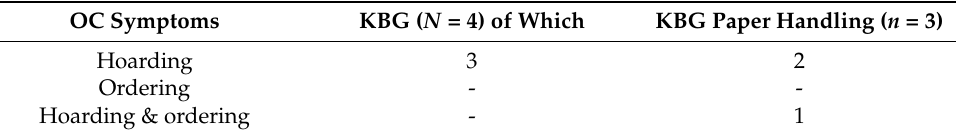
Table 2. Obsessive compulsive symptoms and “paper handling” activities in 4 newly diagnosed KBGS (KBG syndrome) subjects. OC = obsessive-compulsive). OC Symptoms KBG ( N = 4) of Which KBG Paper Handling ( n = 3) Hoarding 3 2 Ordering - - Hoarding & ordering -